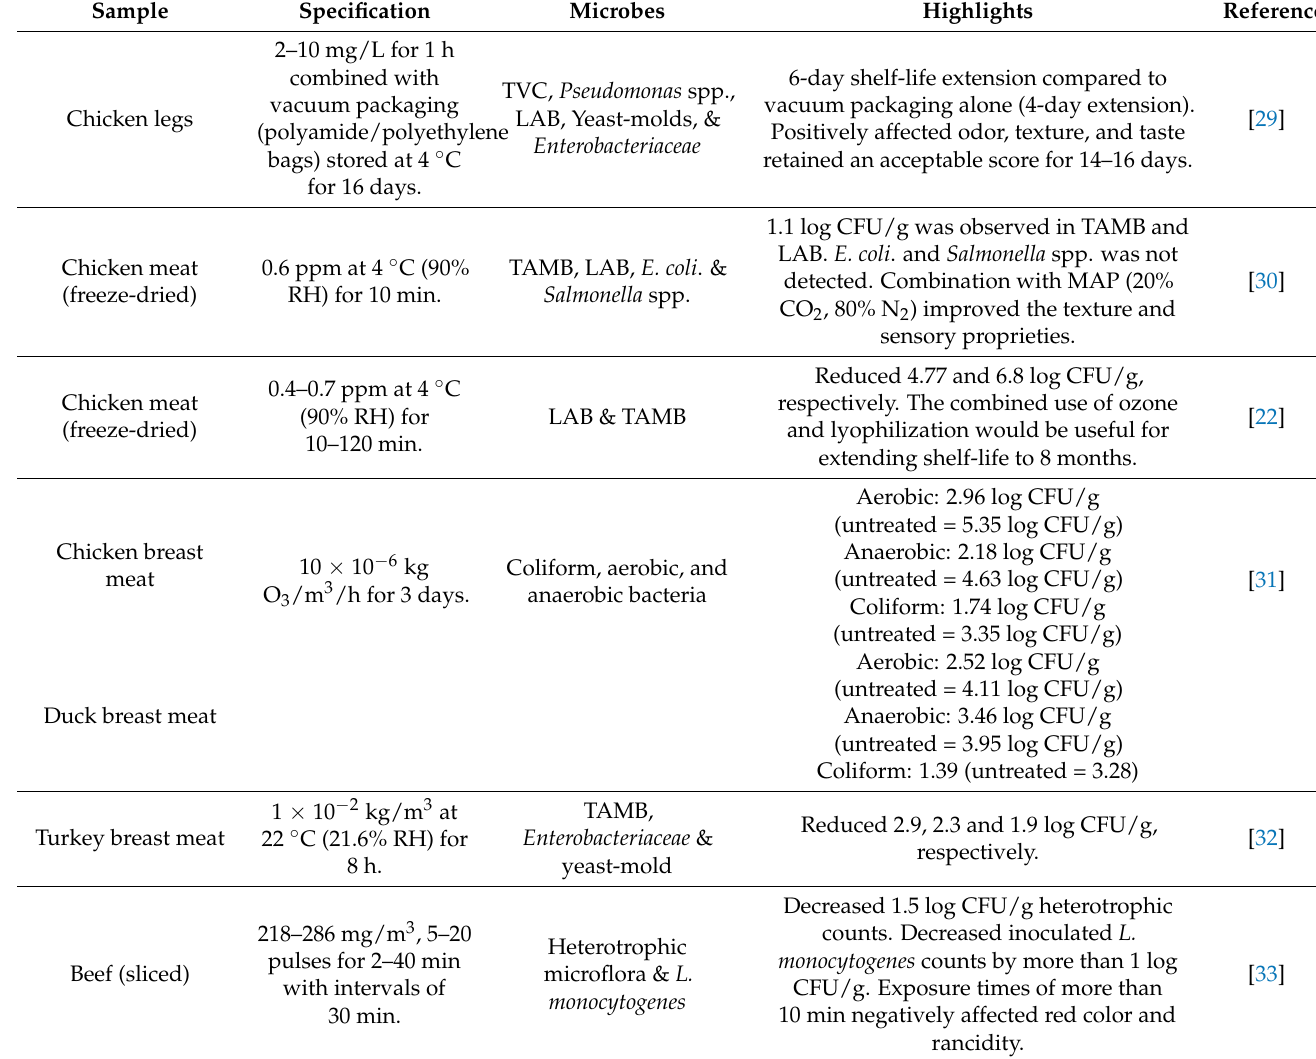
Table 1. Ozone applications to decontaminate meat and meat products.